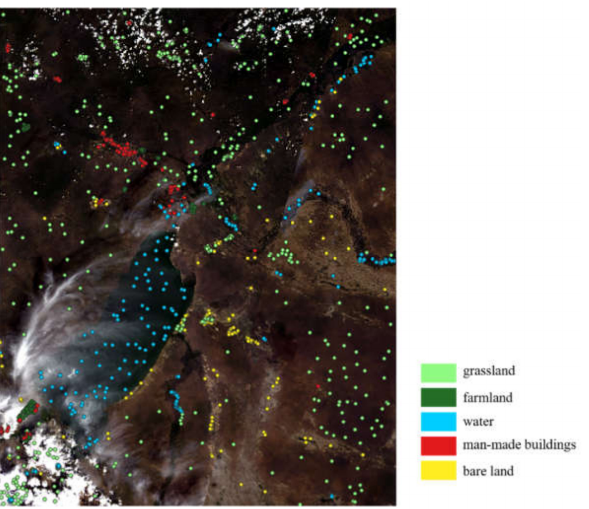
Figure 4. Examples of typical samples and methods to assist with labeling. ( Top : MS remote sensing image from Landsat-8. Middle : super-high-resolution RGB image from Google Earth. Bottom : multi-temporal NDVI index curves and spectral curves generated by Google Earth Engine).